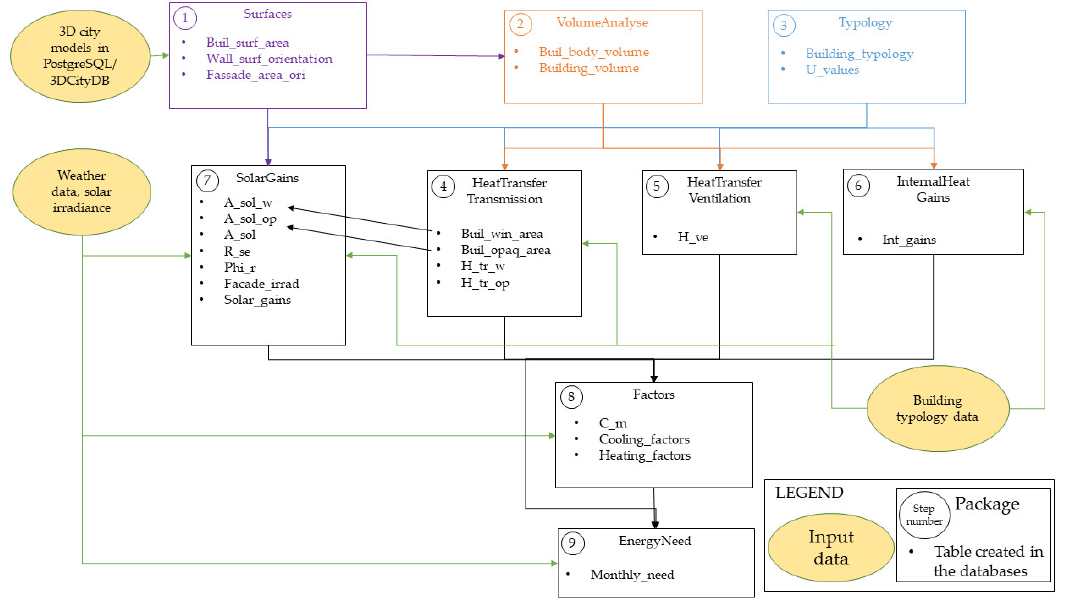
Figure 3. Implementation steps of the CityBEM model: Different input data, related software packages and the tables created in the databases.